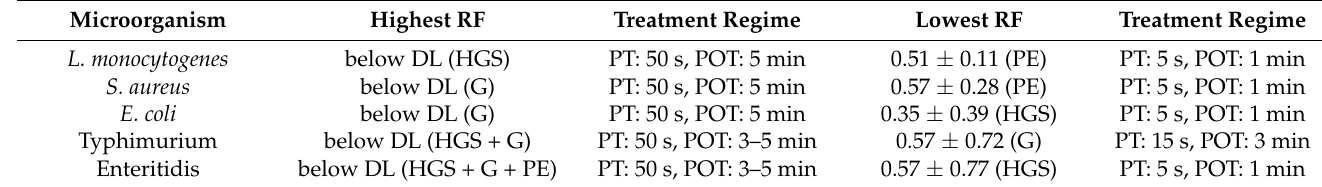
Figure 2. Inactivation kinetics of various microorganisms ( L. monocytogenes , E. coli , S. aureus , Ty- phimurium , and Enteritidis ) on PE, G, and HGS surfaces. All specimens underwent a maximum POT of 5 min. The PPA was produced in a 5 s PT ( a ), 15 s PT ( b ), and 50 s PT ( c ). The graphs embrace the arithmetic means ( N = 5) and the standard deviations. Table 4. Summary of extreme RF values categorized after the range of tested